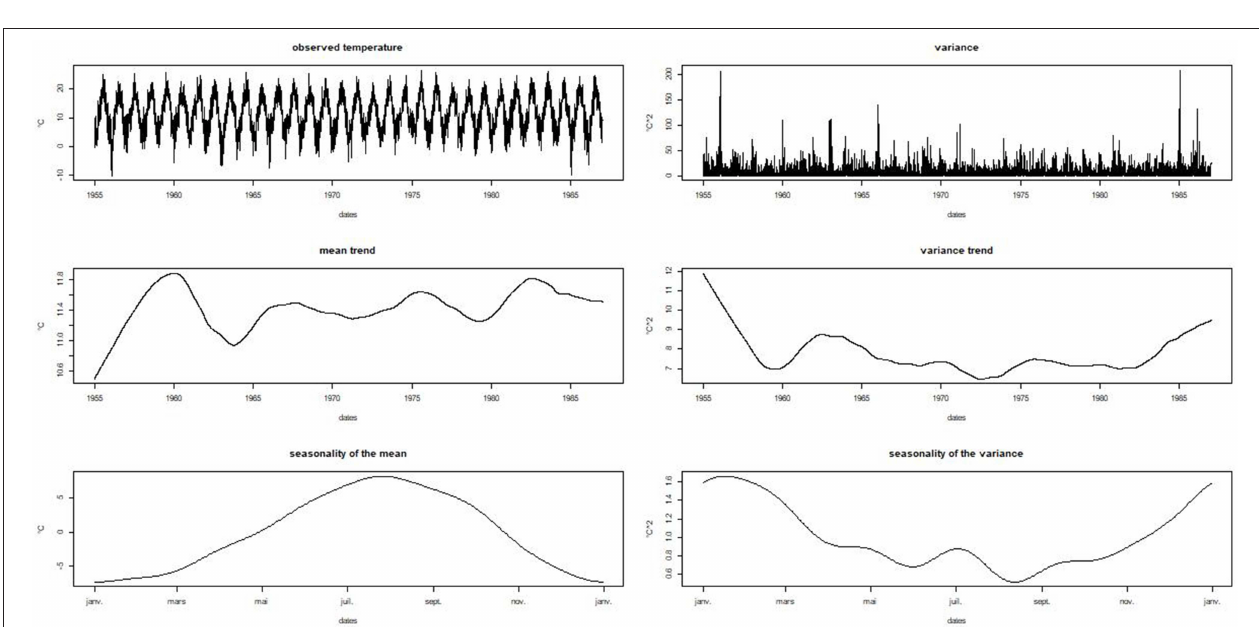
FIGURE 2 | Observed indicator from 1950 to 2017 (top left panel), non-parametric trend in mean (middle left panel), seasonality of the mean (bottom left panel), evolution of the variance (top right panel), non-parametric trend in variance (middle right panel), and seasonality of the variance (bottom right panel). Black curves are for the total period and red curves for period 1955–1986.